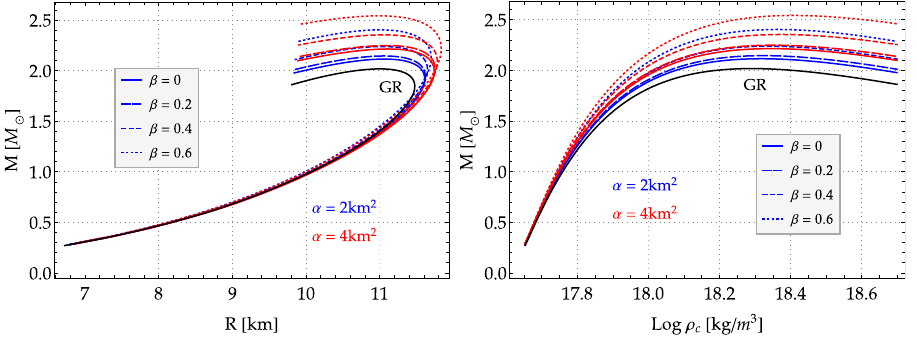
Fig. 3 Mass-radiusdiagram(leftpanel)andmass–centraldensityrela- tion (right panel) for charged quark stars in 4 D EGB gravity. The blue and red lines correspond to α = 2 km 2 and α = 4 km 2 , respectively. Moreover, different styles of the curves stand for different values of the chargeparameter β ,andthenon-chargedGRcaseisshowninbothplots as a benchmark by the black solid line. We note that the gravitational Fig. 4 The total charge as a function of the radius (left panel) and of the mass (right panel). The results for the several values of the parameter β as in Fig. 3 are shown. It is observed that the electric charge undergoes relevant changes due to the GB term only in the high-mass region